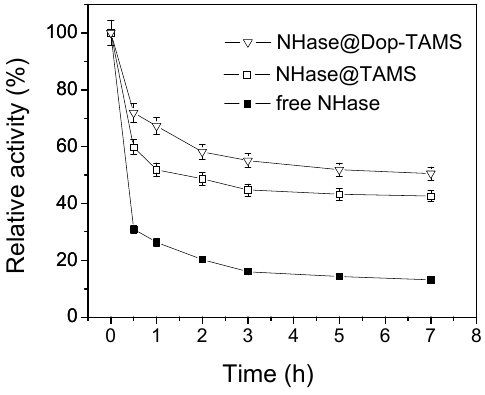
Figure 5. The thermal stability of free and immobilized NHase.